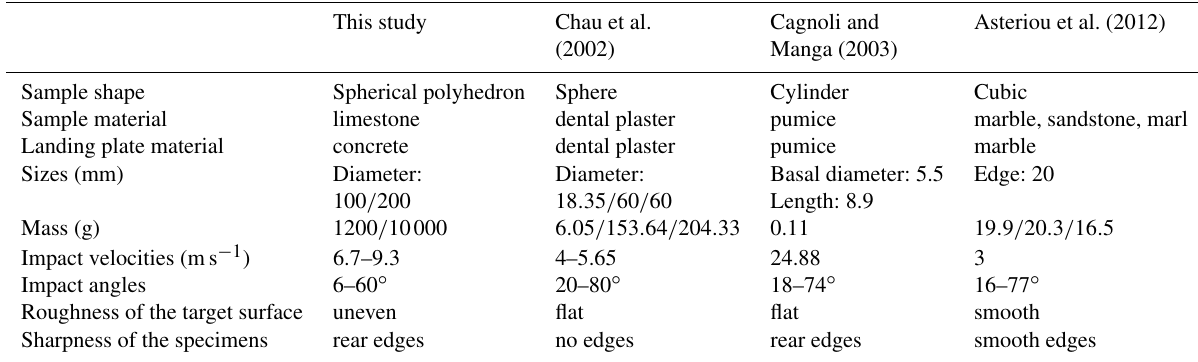
Table 2. Test conditions of previous studies and our experiment.